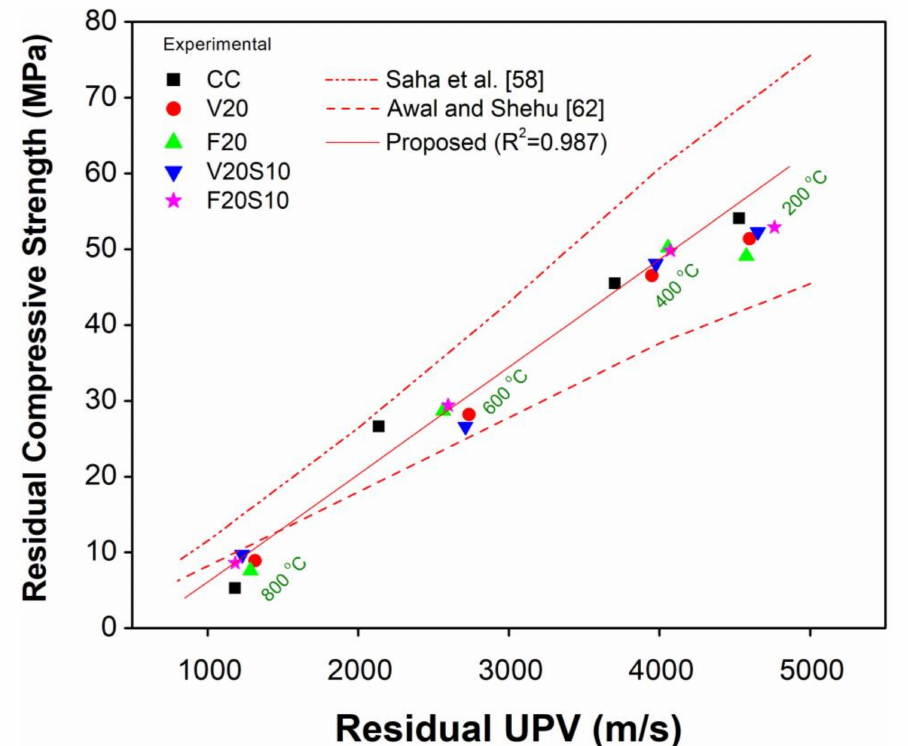
Figure 11. Relationship between residual compressive strength and UPV for control and concrete incorporating VA and